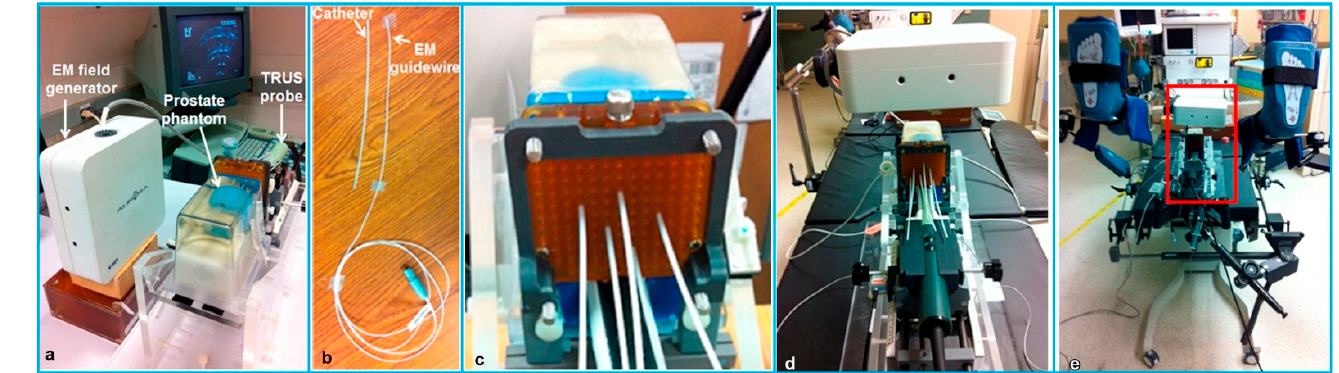
Figure 17. The experimental setup for catheter tracking in a controlled laboratory environment ( a – c ) and in a brachytherapy operating room ( d , e ). ( a ) The experimental phantom setup; ( b ) The flexible electromagnetic-tracked guidewire and catheter; ( c ) Catheters inserted into the prostate model through the grid; ( d ) The experimental setup positioned on the treatment table in the operating room; ( e ) Mimicking a typical brachytherapy setup. Reprinted from [177] with permission.